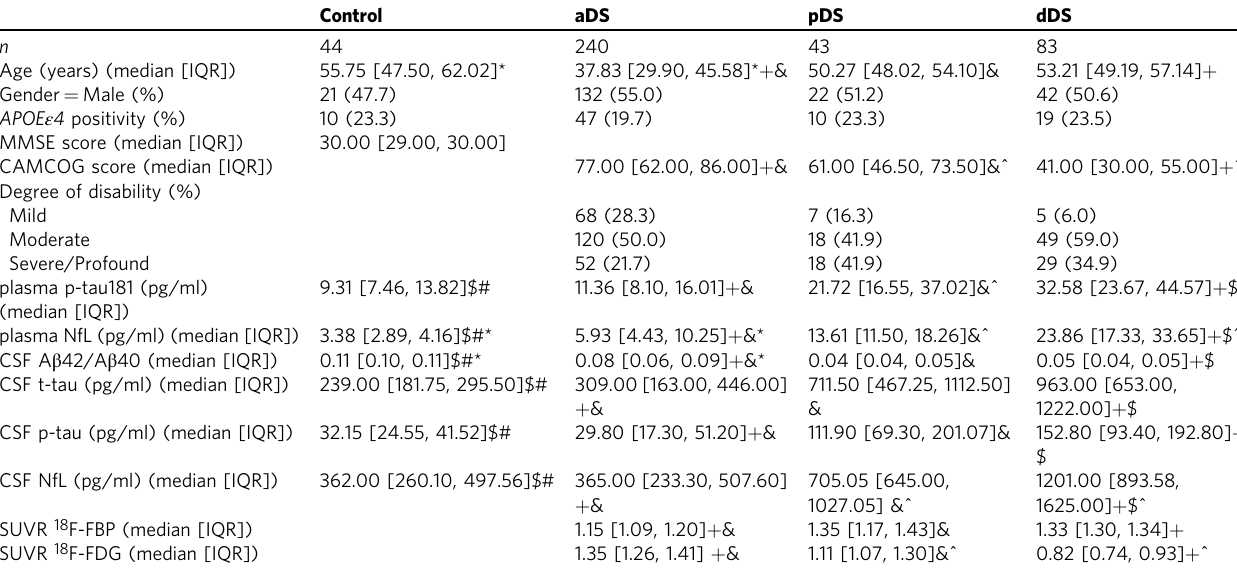
Table 1 Demographics, cognitive and biomarker data of participants with Down syndrome and controls.